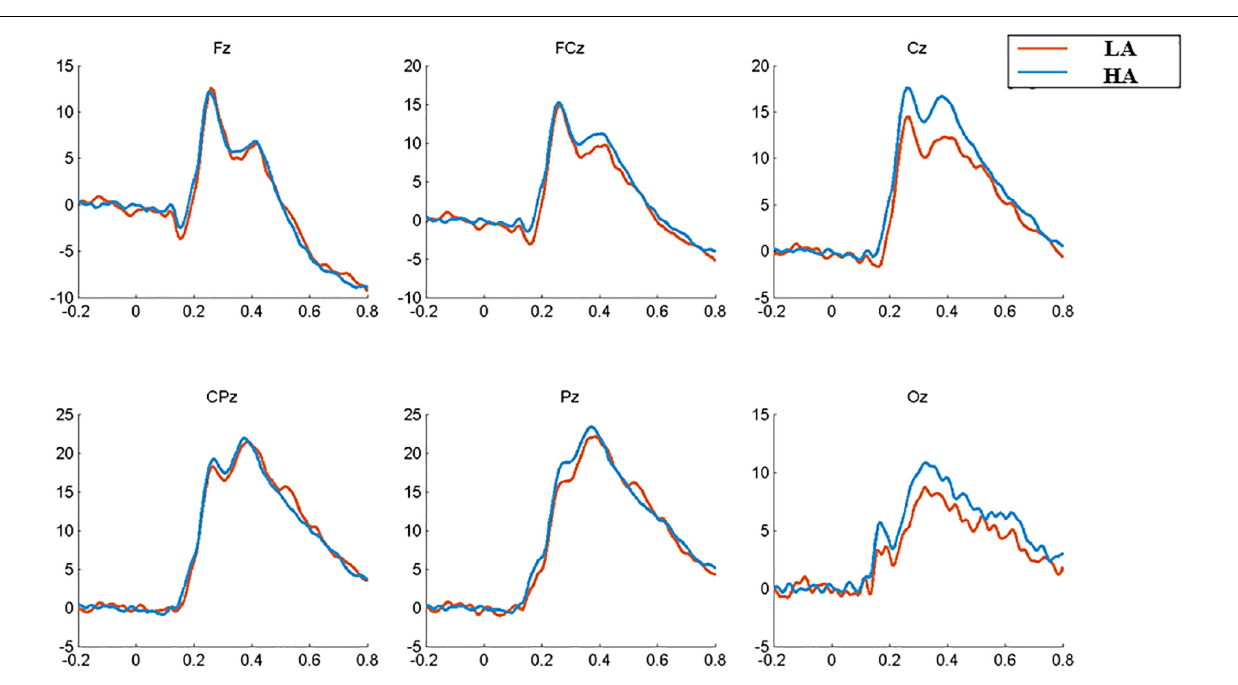
FIGURE 2 | Average ERP waveforms for 2-back task of LA (red) and HA (blue) groups.